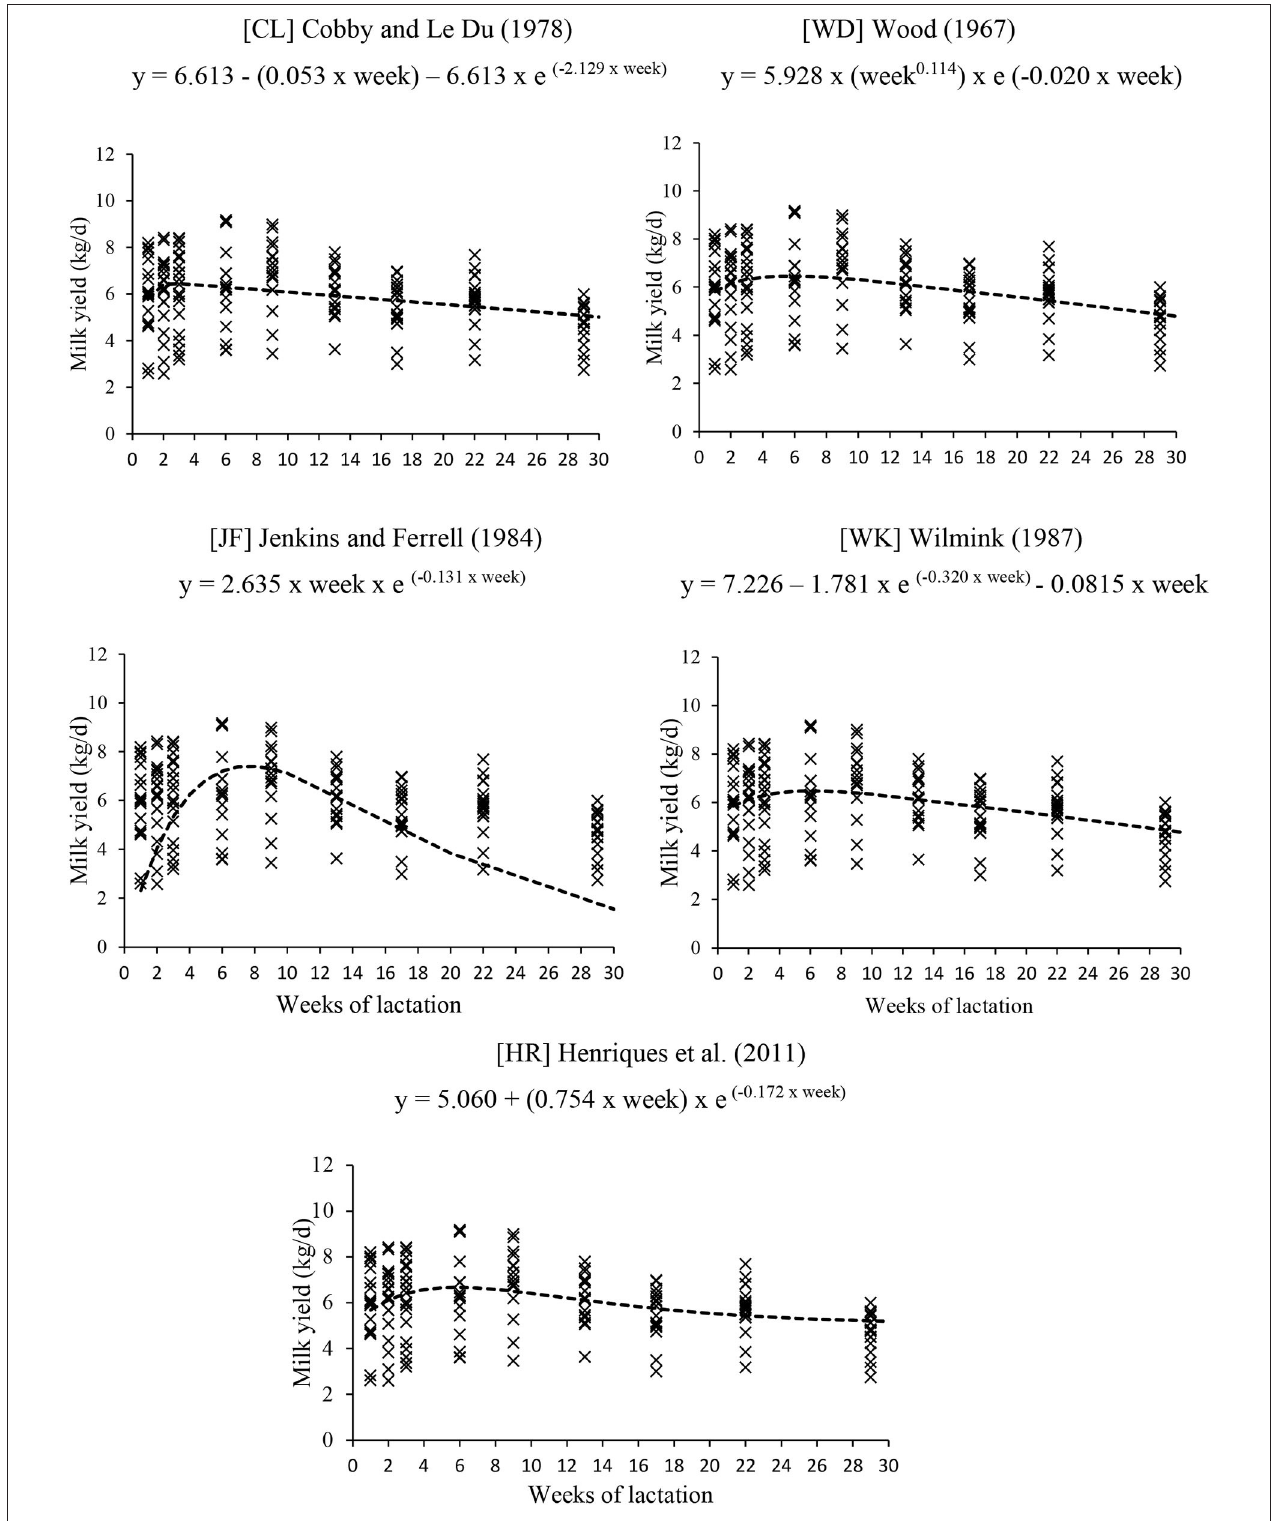
FIGURE 5 | Equations to predict milk yield of nulliparous and primiparous cows under grazing.